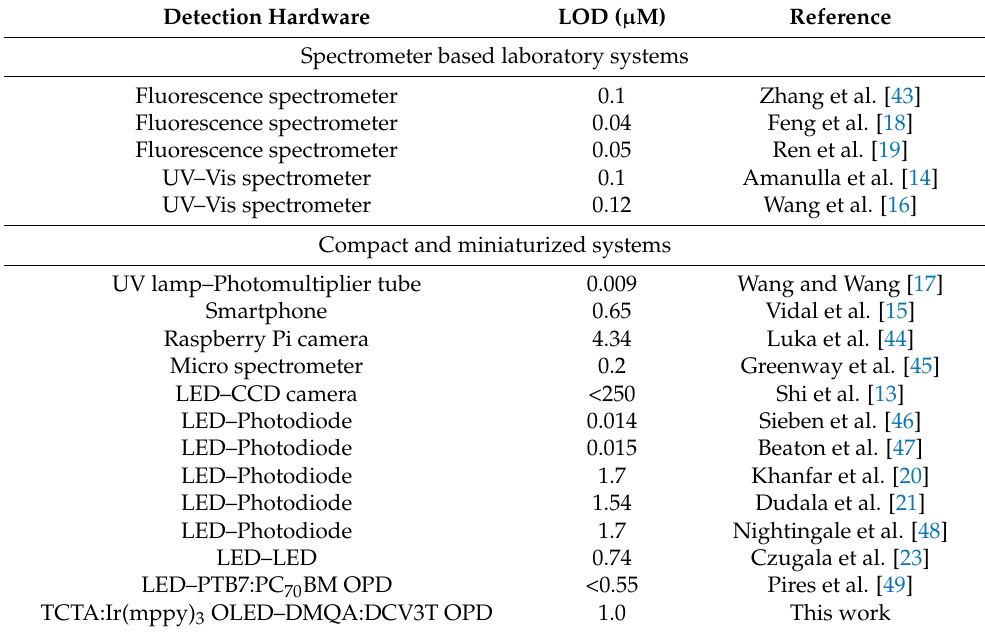
Table 1. Sensing performance comparison of investigated OLED–OPD unit and recently reported photometric nitrite